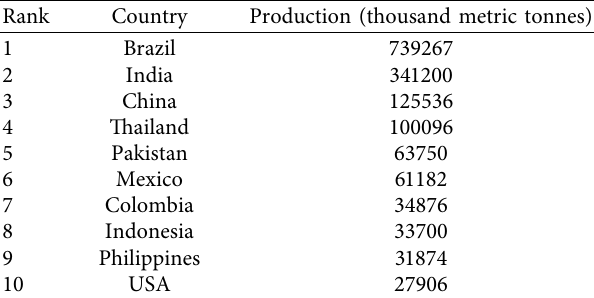
Table 2: Top 10 sugarcane producers [14–16].